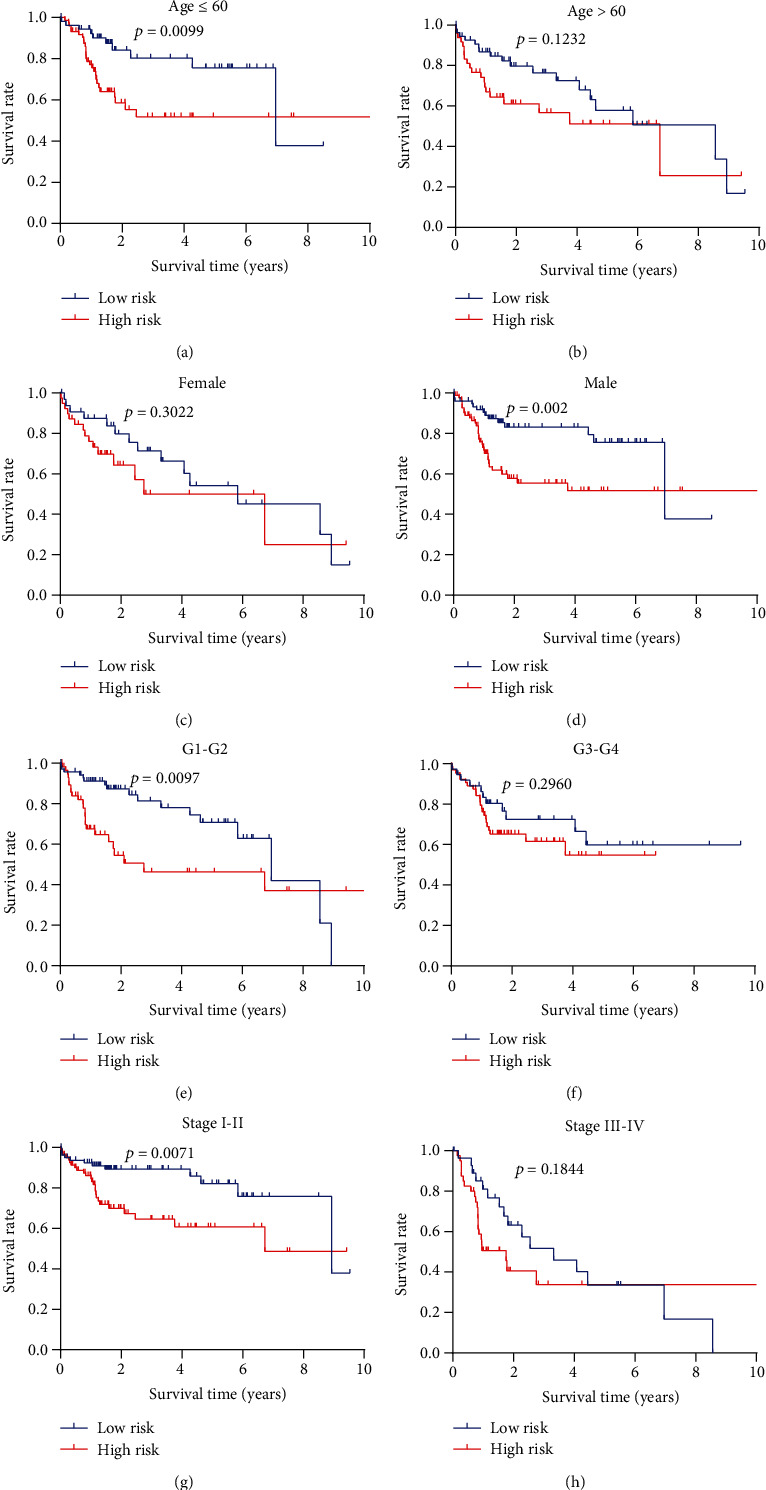
Prognostic value of the risk signature in hepatocellular carcinoma patients classified into specific cohorts. The Kaplan–Meier survival curve for patients with (a) age < = 60, (b) age > 60, (c) female, (d) male, (e) grade 1-grade 2, (f) grade 3-grade 4, (g) stages I-II, (h) stages III-IV.